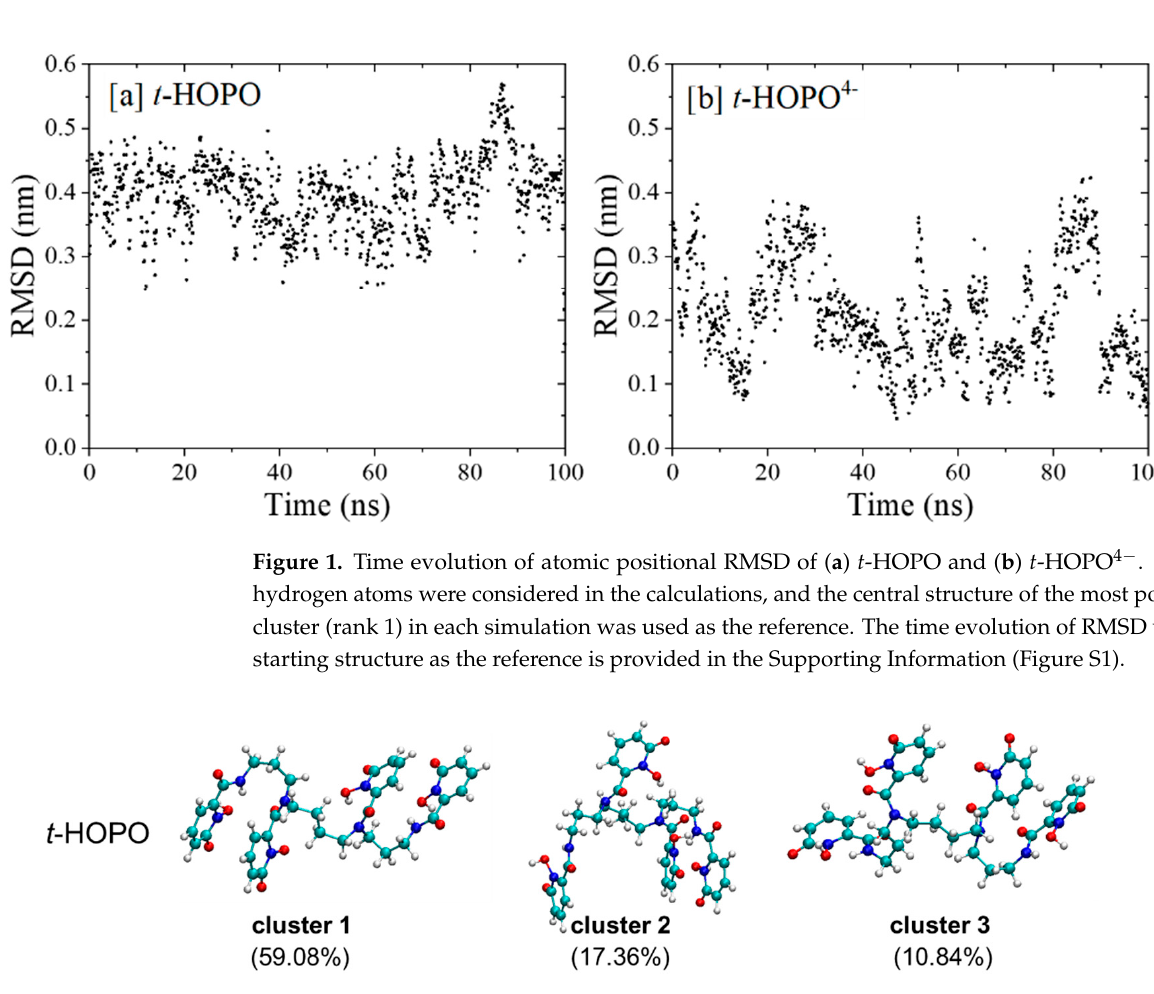
Figure 2. The central structures of top three clusters in the simulations of t- HOPO in its neutral (top) and deprotonated (bottom) states. The cutoff of t- HOPO is 0.35 nm, and the cutoff of t- HOPO 4 − is 0.18 nm. Color scheme: N atoms in blue, O atoms in red, C atoms in cyan and H atoms in white.